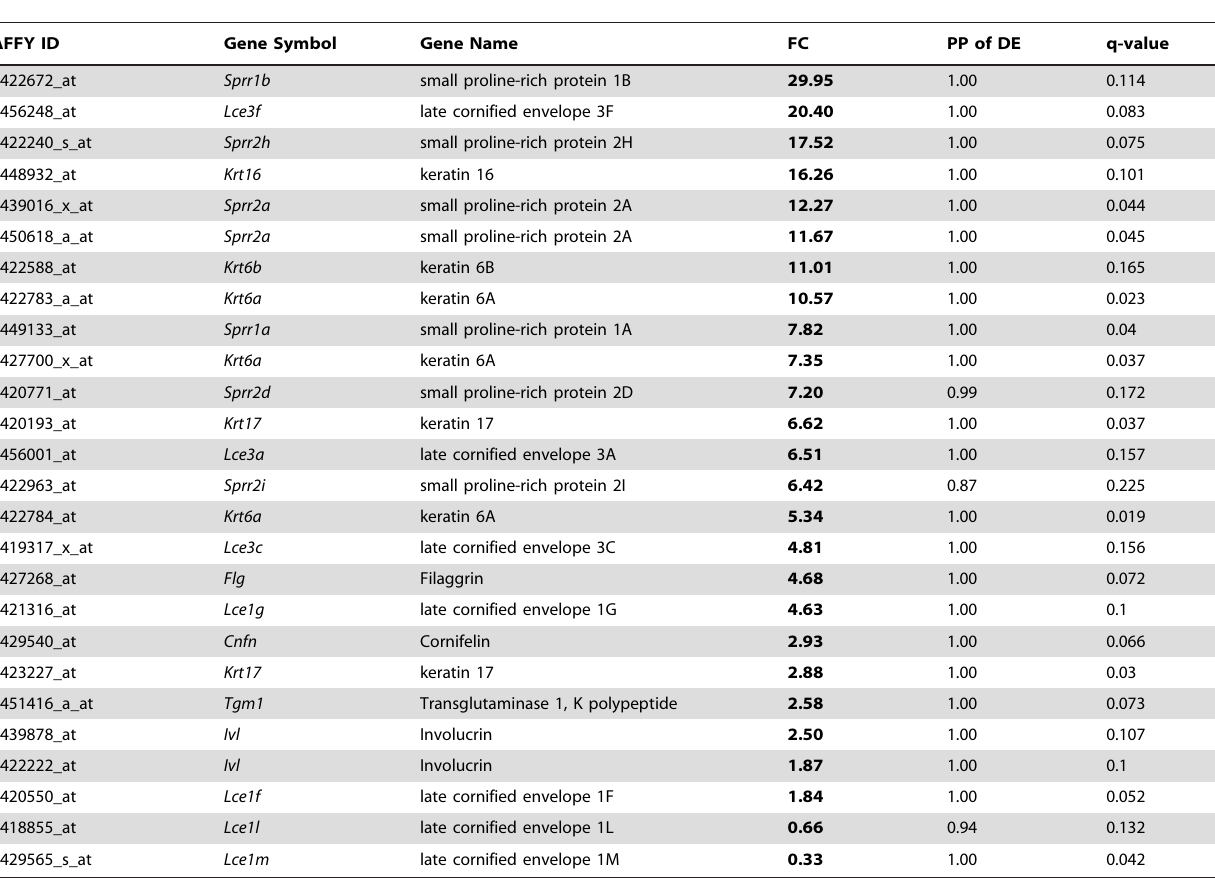
Table 4. Keratinocyte differentiation and activation; epidermal barrier